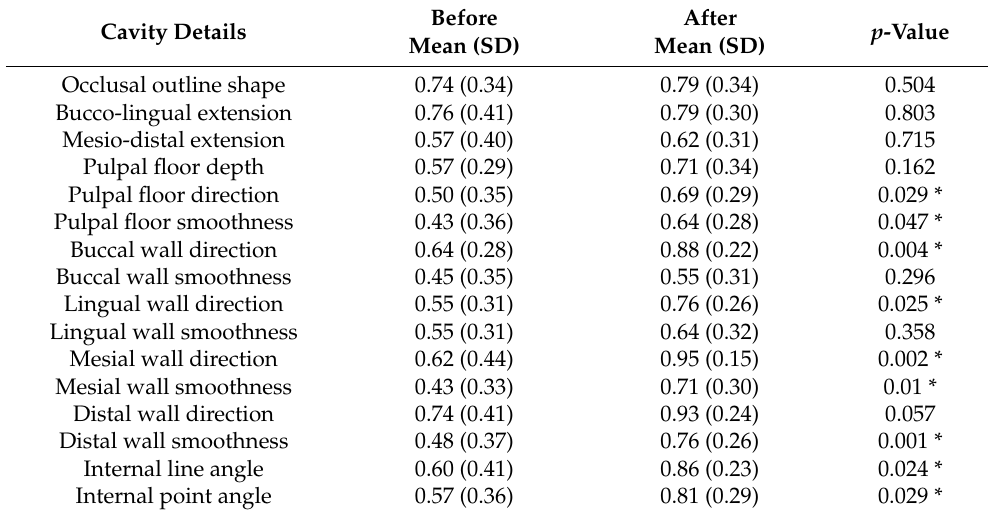
Table 3. The mean of students’ performance in cavity preparation before and after HVRS training. Cavity